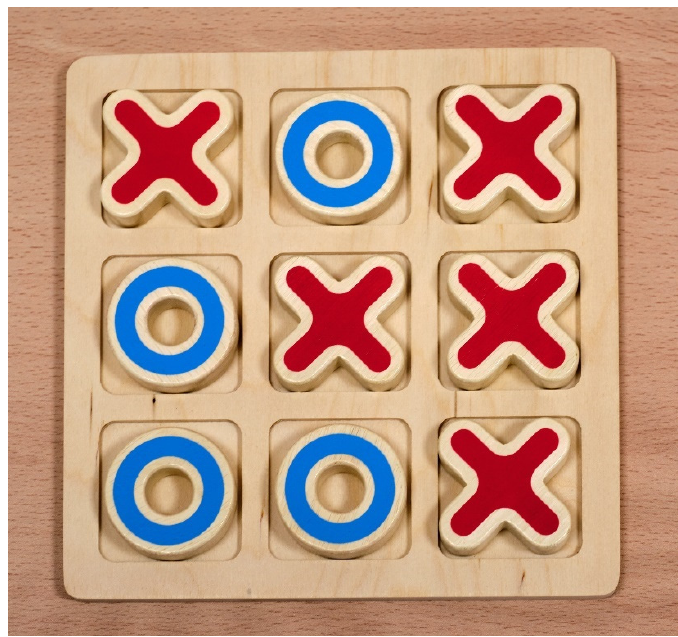
Figure 1. A finished game of tic-tac-toe, won by player X.